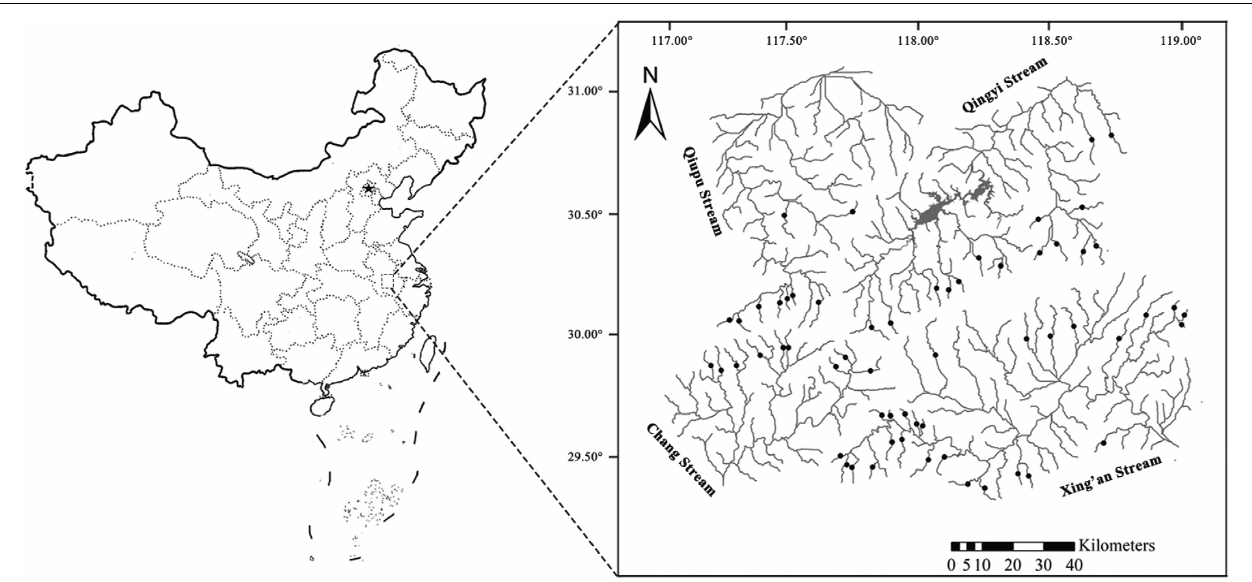
FIGURE 1 | Map showing the survey of low-head dams distributed among four basins in the Wannan Mountains, China. One impoundment area and one free-flowing segment were sampled for each